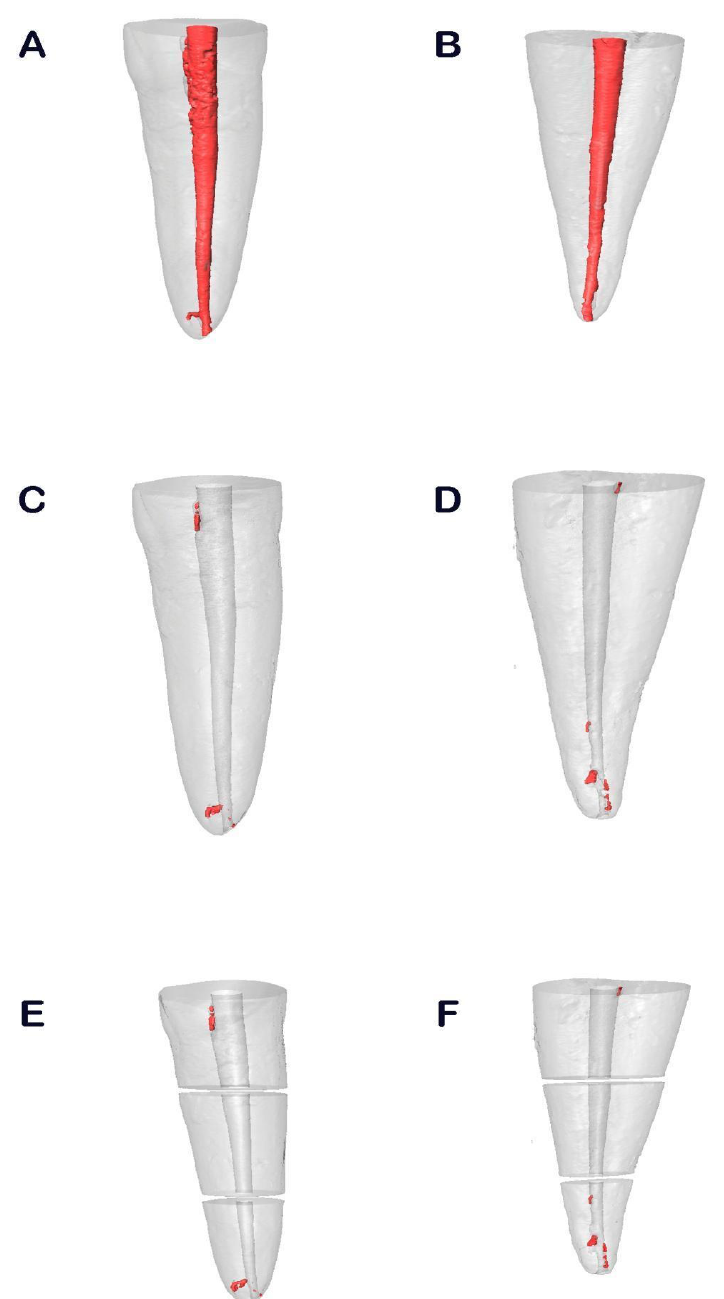
Figure 1. Reconstructed three-dimensional micro-computed tomography (CT) images of the GuttaCore ( A ) and Thermafil root canal filling materials ( B ), after non-surgical root canal re-treatment of GuttaCore ( C ) and Thermafil root canal filling materials ( D ). The results were expressed in thirds both in GuttaCore ( E ) and Thermafil root canal filling materials ( F ).